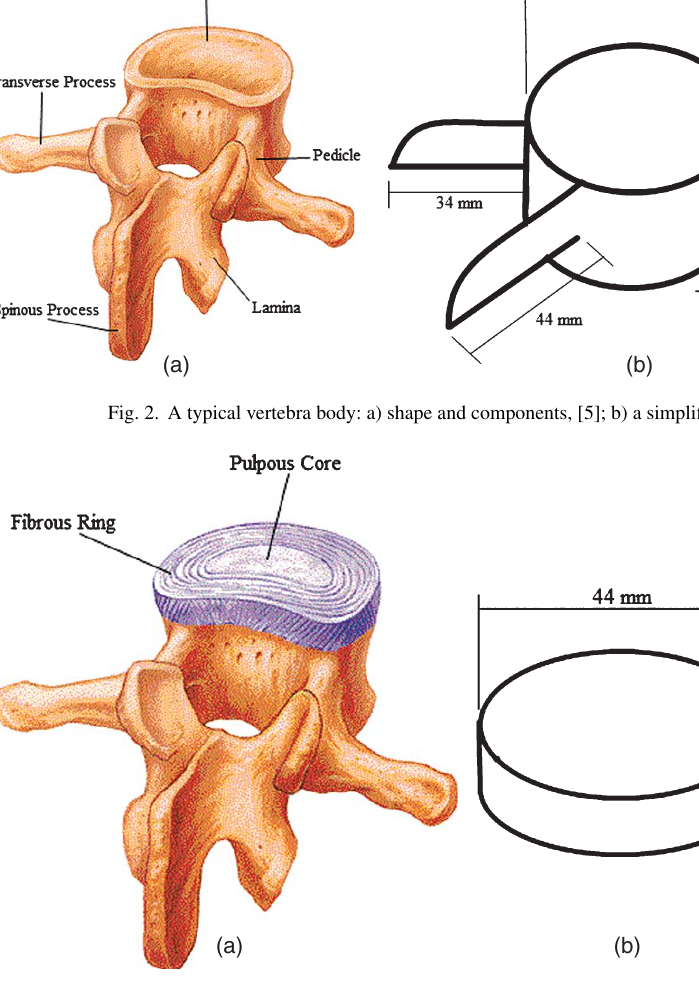
Fig. 3. The intervertebral disc: a) shape and components, [5]; b) a simplified